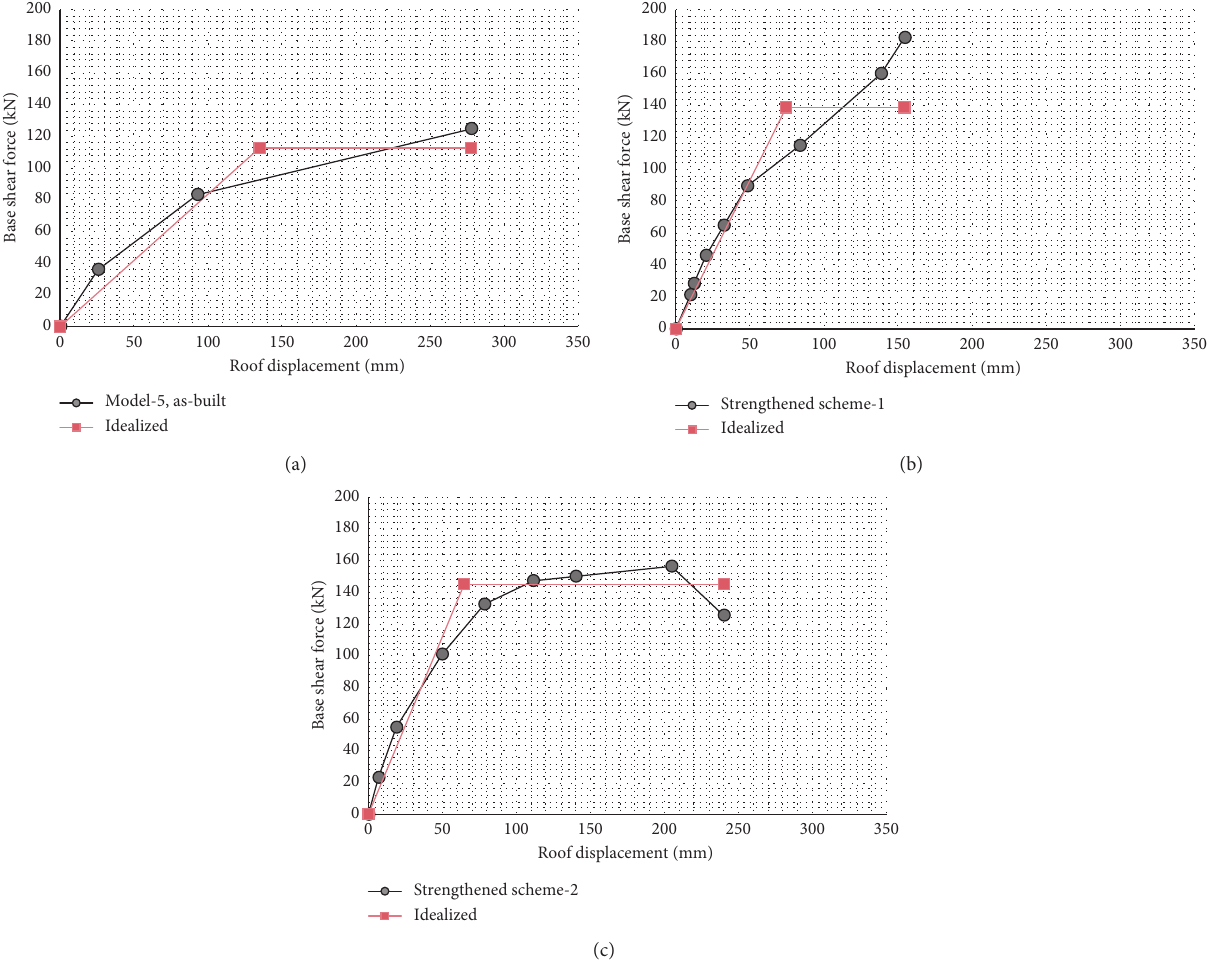
Figure 16: Bilinear idealizations of force-displacement capacity curves. (a) Model-5, as-built [19]. (b) Retrofitted, scheme-1. (c) Retrofitted, scheme-2. Elastoplastic idealization of capacity curves. First, the maximum displacement capacity of models was identified. The yield force and yield displacement were varied to equalize the area under the elastoplastic curve to that of actual curve. The yield stiffness was checked not to vary much in comparison to initial stiffness.